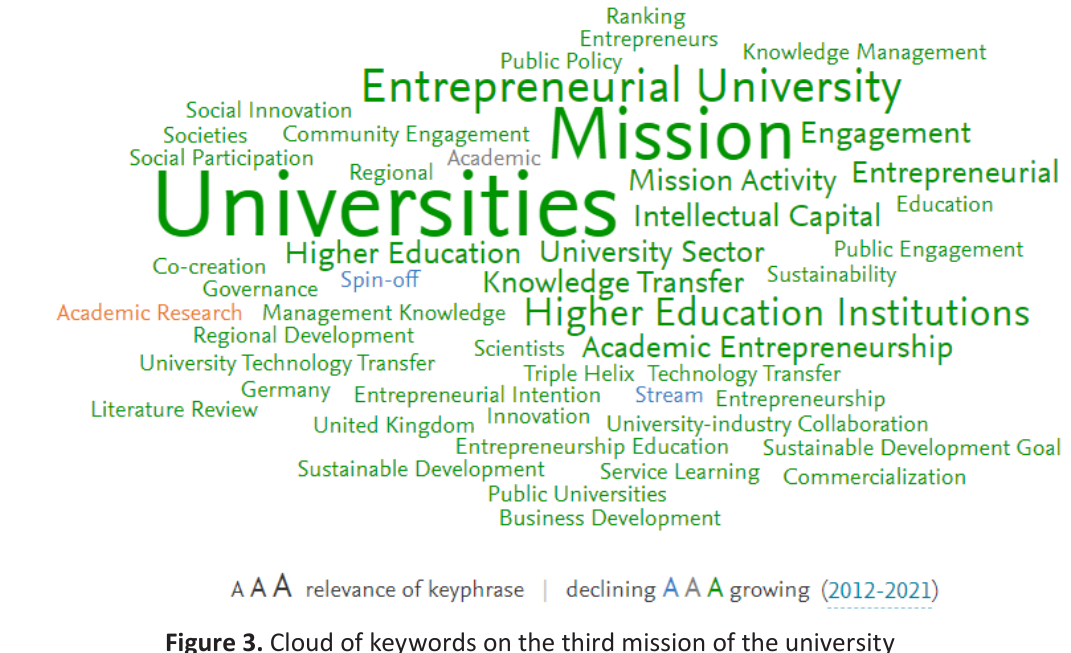
Figure 3. Cloud of keywords on the third mission of the university in the Scopus database for